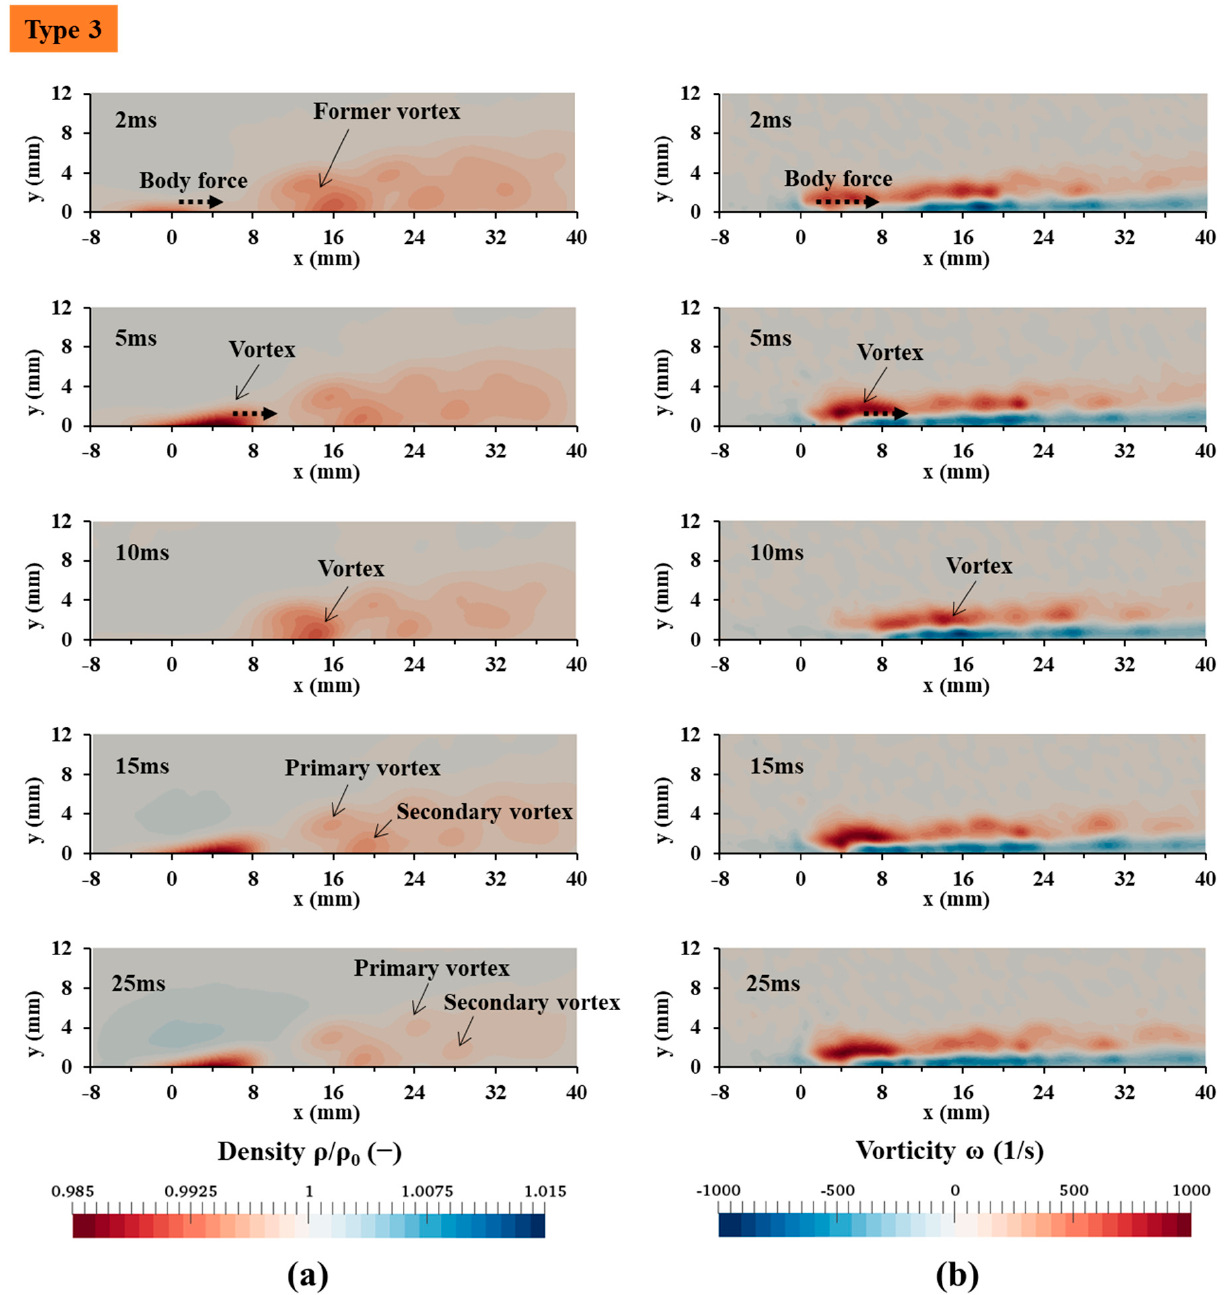
Figure 10. Time-series of ( a ) density field and ( b ) vorticity field contours in burst modulation at F = 7.2 kHz, BR = 40% and T on = 4 ( f + = 100 Hz), 2, 5, 10, 15, and 25 ms after turning on the burst signal input.